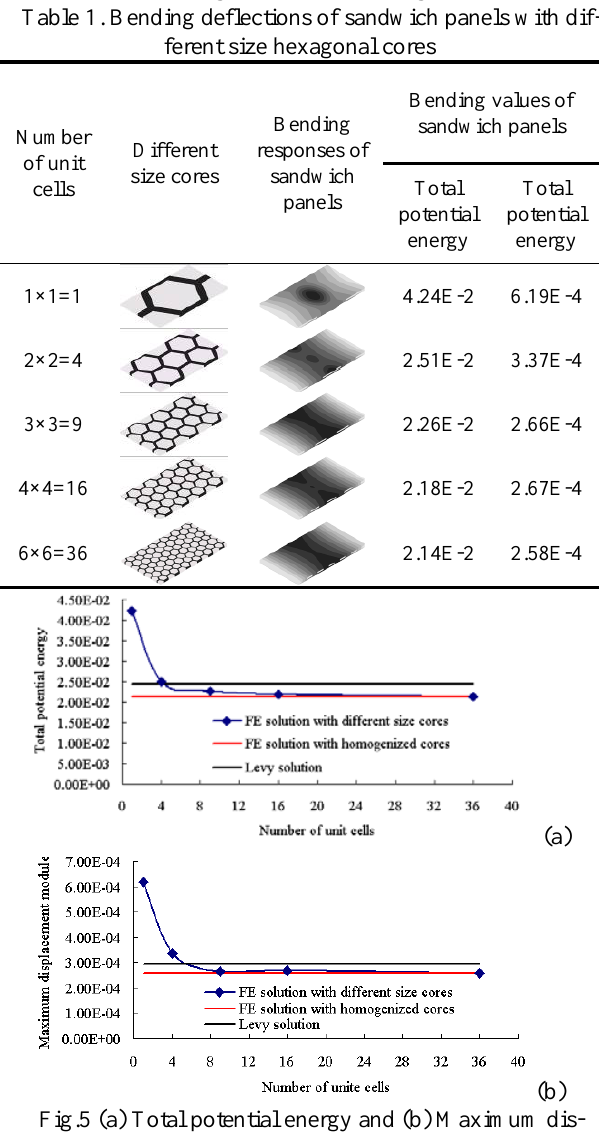
Bending lues of Total Total potential potential energy